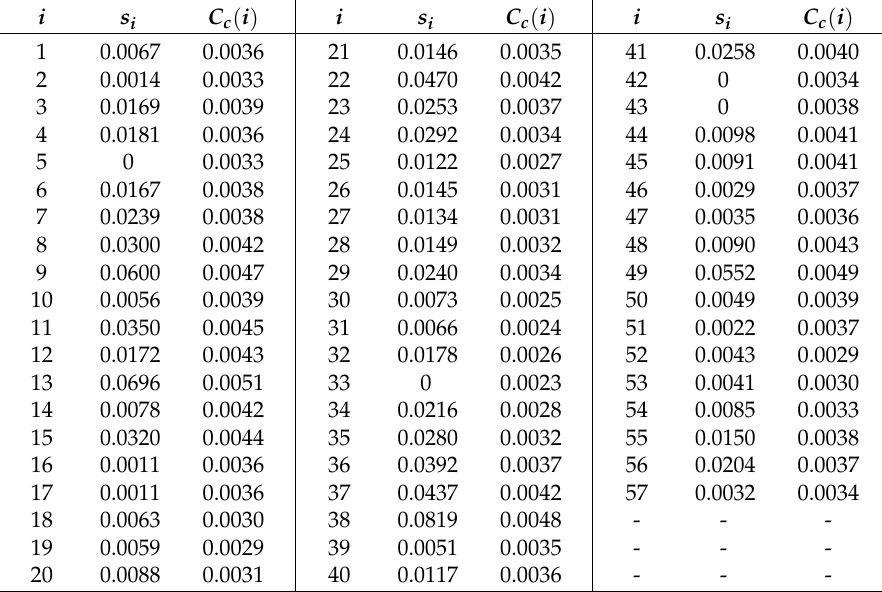
Table A4. The betweennesses and closeness centralities of physical nodes.